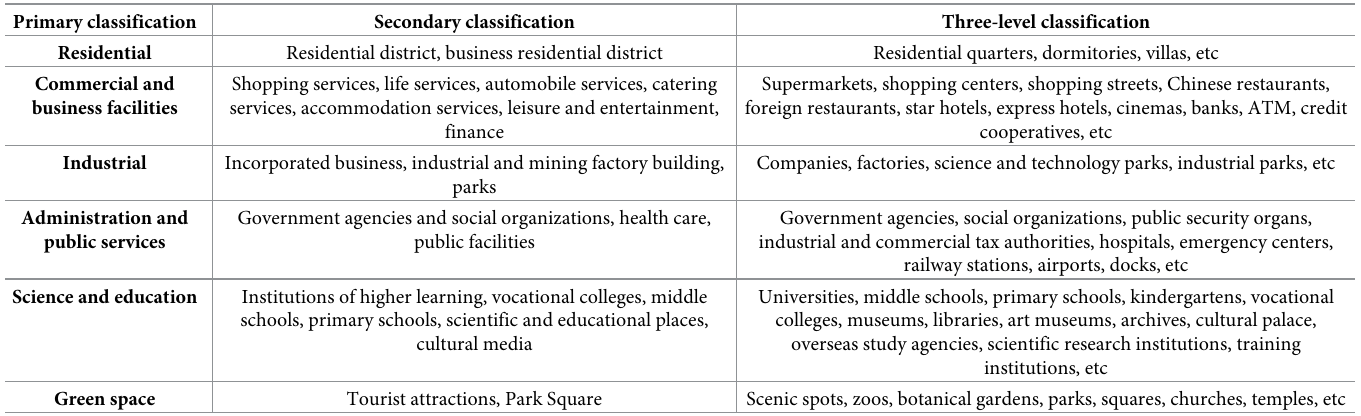
Table 1. POI classification